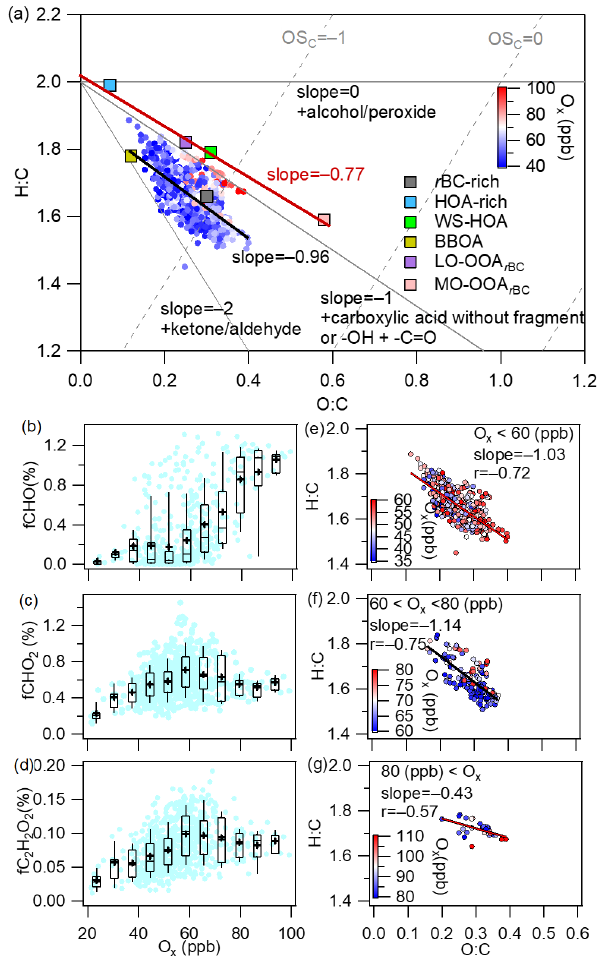
Figure 9. (a) Van Krevelen diagram of the H / C ratio versus the O / C ratio for all rBCc-particle OA and the six factors colored by O x concentration (the black line represents the linear fit to all OA data, and the red line is the fit to the four OA factors). (b–d) Mass frac- tions of selected oxygenated ion fragments as a function of O x (the meanings of the boxes are the same as those described for Fig. 2). (e–g) Scatter plots of the H / C ratio versus the O / C ratio at different O x levels (data are colored by O x